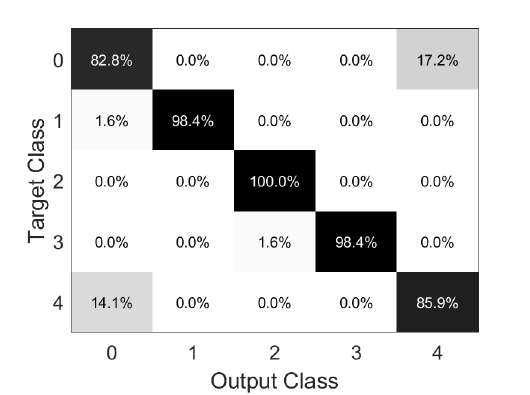
Figure 3. Confusion matrix relevant to damage